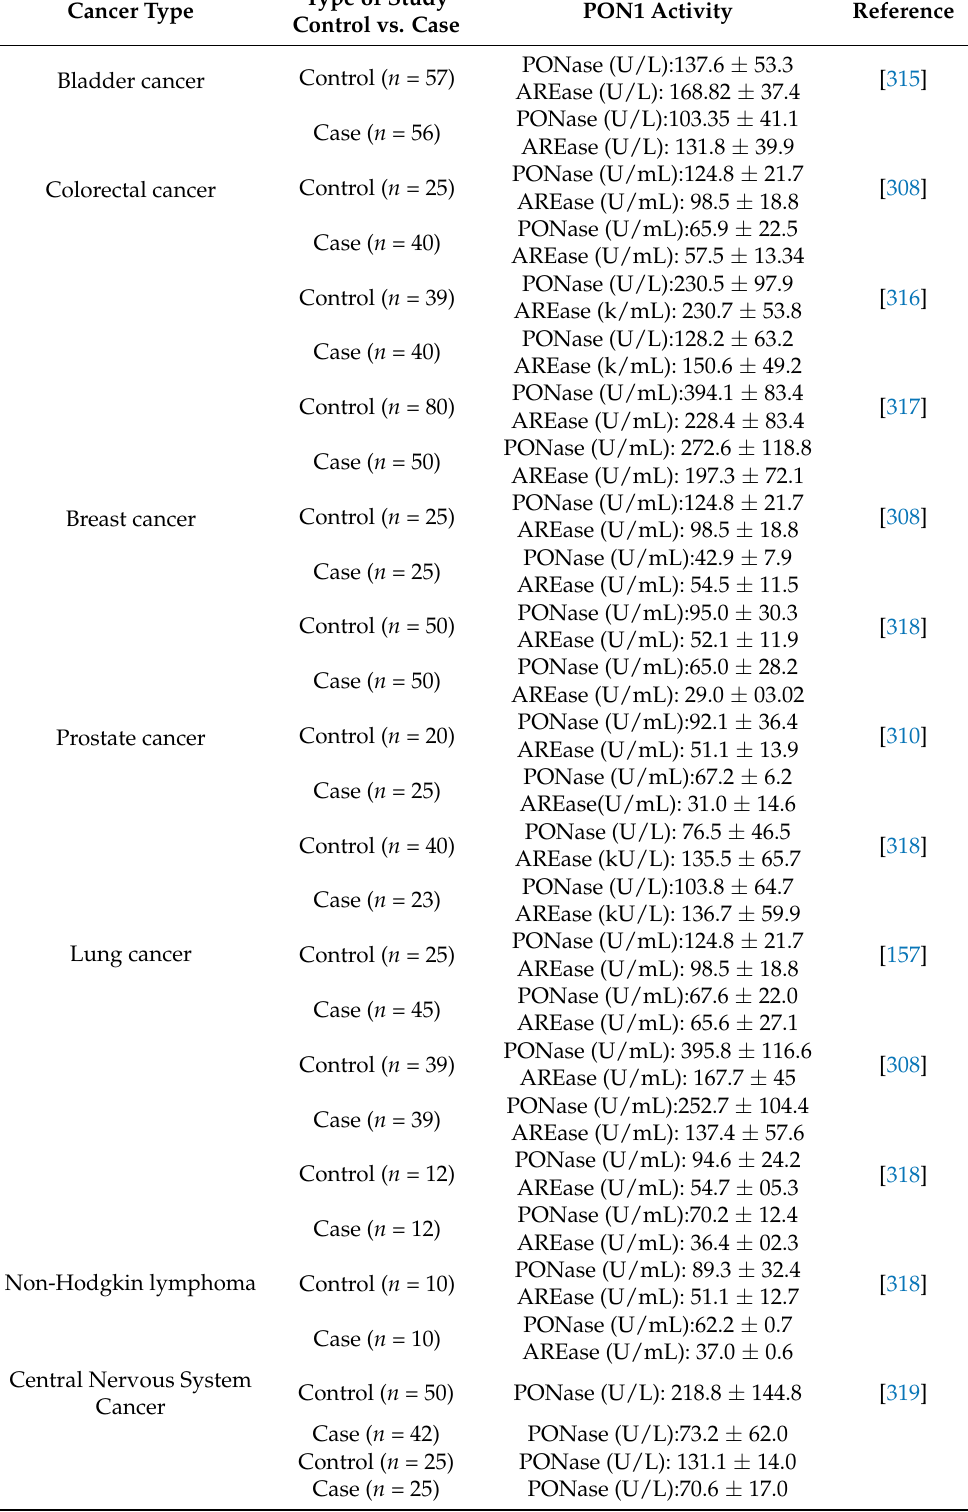
Table 4. Human studies and PON activity of patients with serval type of